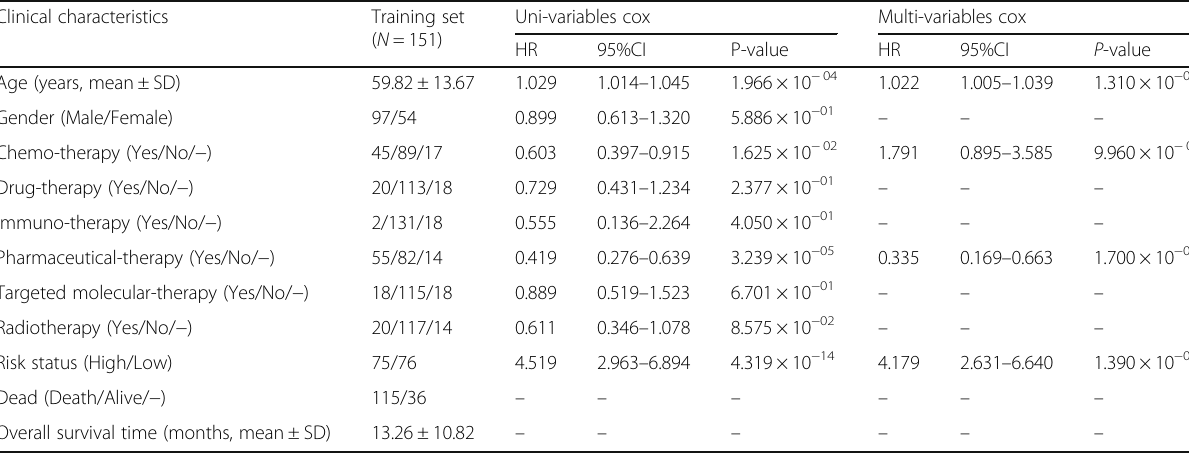
Table 3 Determination of prognostic clinical factors